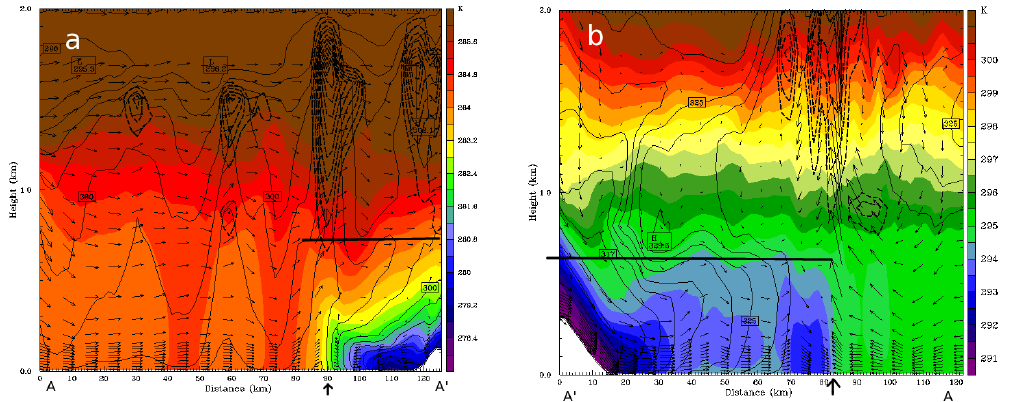
Figure 7. Vertical cross section of the potential temperature (color-filled contours), equivalent potential temperature (solid lines), liquid- water mixing ratio (dashed lines) and wind field (vectors) along the red line AA’ defined in Fig. 2 at 03:00UTC for the (a) GEN event (maximum horizontal wind vector 12.8ms − 1 and vertical 22.1cms − 1 ) and (b) IP event (maximum horizontal wind vector 10.2ms − 1 , vertical 58cms − 1 ). The black arrow indicates the horizontal location of the front. The horizontal black line indicates the vertical location (depth) of the front. The estimated coastal-front depth, H , is about 700m for both density currents, and the simulated LFC at 03:00UTC is 582 and 650m for the GEN and IP cases,